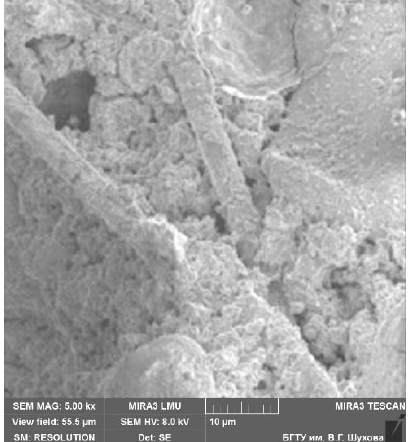
Figure 12. The nature of the adhesion of the fiber to the binding matrix.